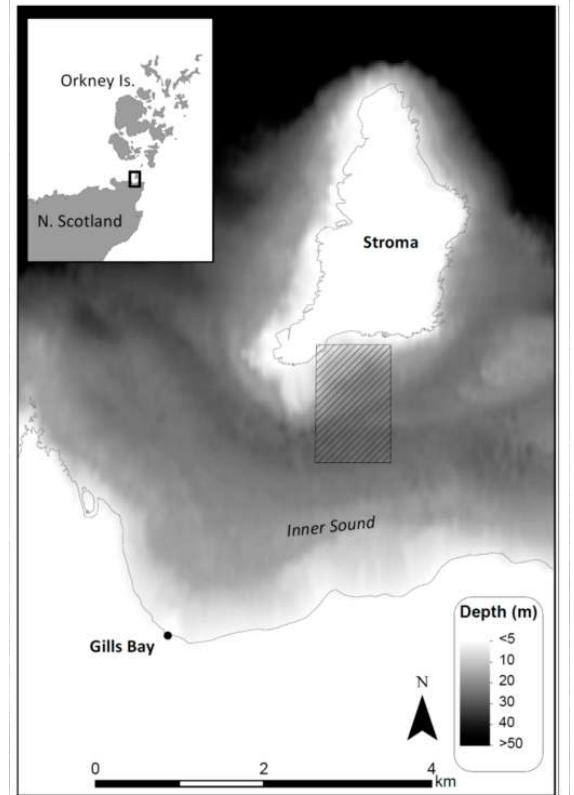
Figure 1. Location chart for the three-frequency acoustic colour sidescan sonar survey of the seabed in the Inner Sound of the Pentland Firth between Stroma Island and Gills Bay, northern Scotland on 8 September